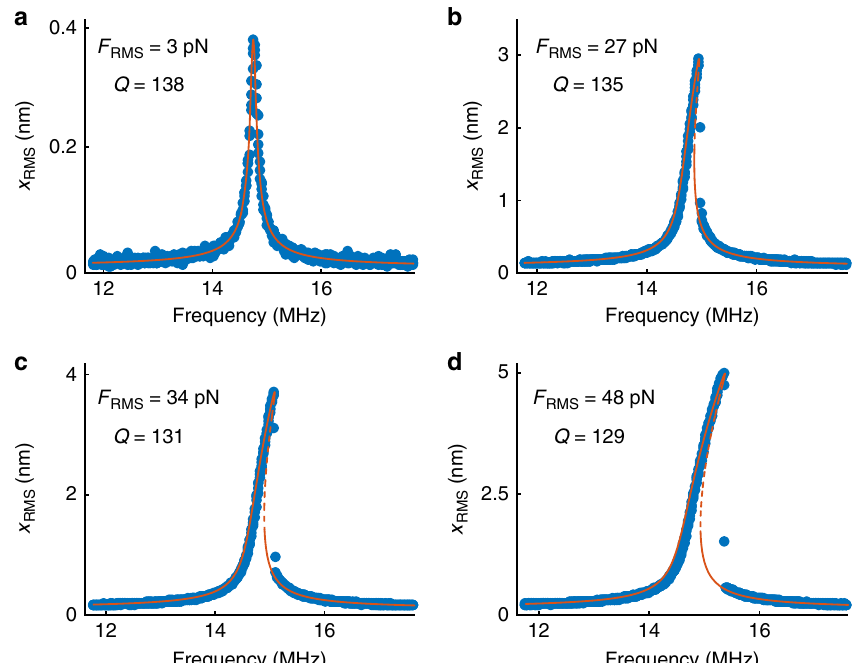
Fig. 2 Measurements and fi ts of the nonlinear frequency response curves of device 1. Measured traces (blue scatter plot) and the corresponding fi ts (red curves) showing both the stable (solid line) and the unstable (dashed line) solutions of the Duf fi ng equation. a – d Frequency response curves of the device from Fig. 1 at four different driving forces, denoted in the top left corner of each panel, along with the extracted Q -factors. The extracted cubic spring constant is k 3 = 1.35 × 10 15 N m −